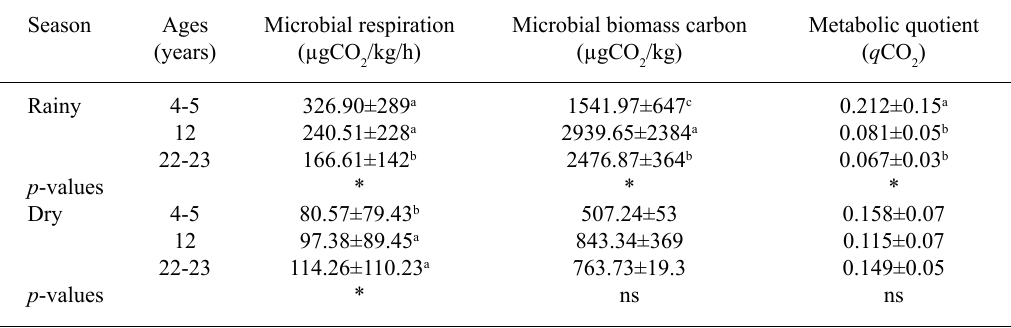
Table 3. Soil biological properties analyses